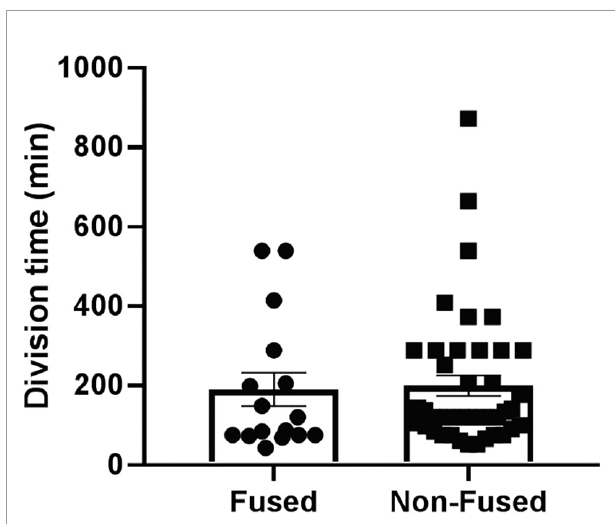
FIGURE 3 | L. monocytogenes cytosolic doubling time. PHT were plated in 35 mm diameter imaging dishes at 2x10 6 cells/dish and cultured for 72 h. Cells were infected with pactA-RFP L. monocytogenes at MOI 1 for 5 h. Cells were transferred to the temperature-controlled microscope stage. The plasma membrane was labeled with CellMask Deep Red dye and the nuclei with Hoechst 33342 ( Figure S3 ). At least four fi elds of view of infected fused and infected non-fused PHT were selected and memorized. Initial sets of phase- contrast and fl uorescence (RFP, DAPI, Deep Red) images were acquired immediately and at 1 h time intervals at the four positions for 2 hours. Z- stacks of the fl uorescent bacteria were acquired to facilitate bacterial counting in 3D. Division time was calculated based on the difference between the initial and fi nal DSRED images using the following equations: growth rate (gr) = (ln [N(t)/N(0)])/t and doubling time = ln (2)/gr, where N(t) is the fi nal number of bacteria, N(0) is the initial number of bacteria, and t is the time point in hours. (n = 3